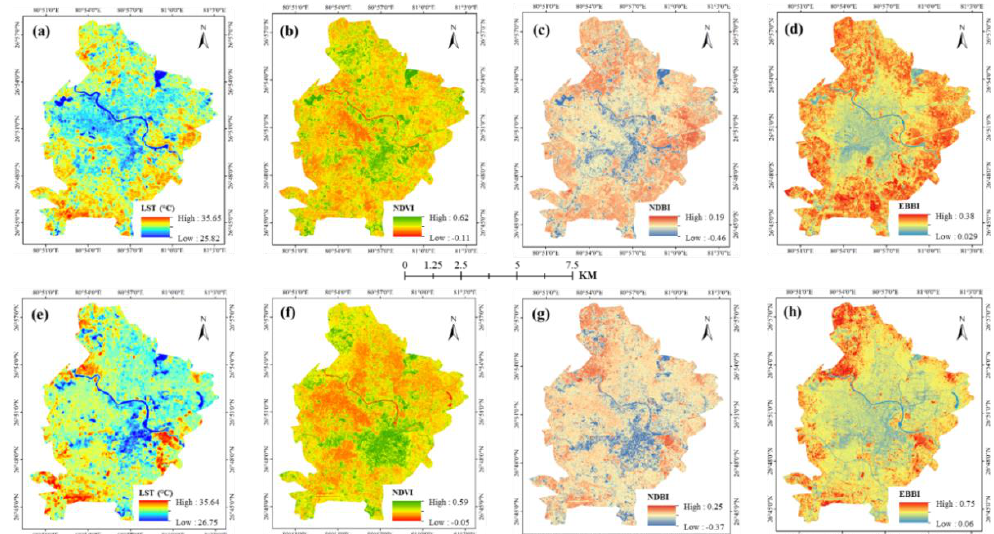
Figure 2. Spatial dynamics of LST and Land Indices (NDVI, NDBI and EBBI) on the Landscape of Lucknow City: (a - d) spatial distribution of LST, NDVI, NDBI, and EBBI respectively of 09/06/1993; (e - f) spatial distribution of LST,